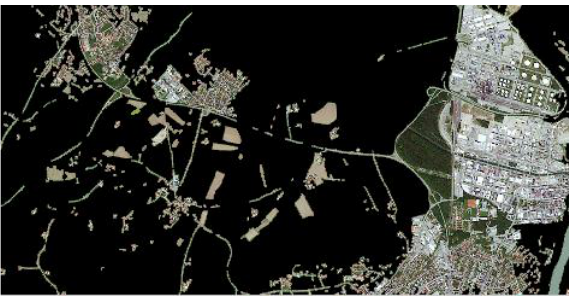
Figure 10. ROI automatic detection by the proposed system of urban of the test image.